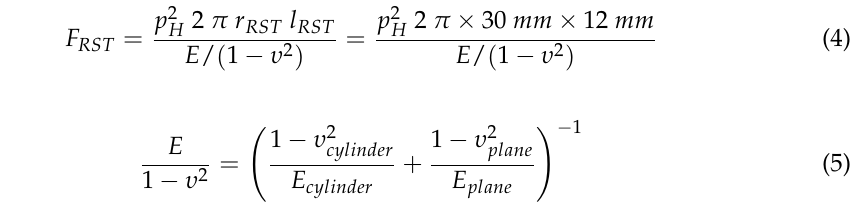
Table 2. Parameters used to determine the axial load curves in the rolling-sliding test bench.